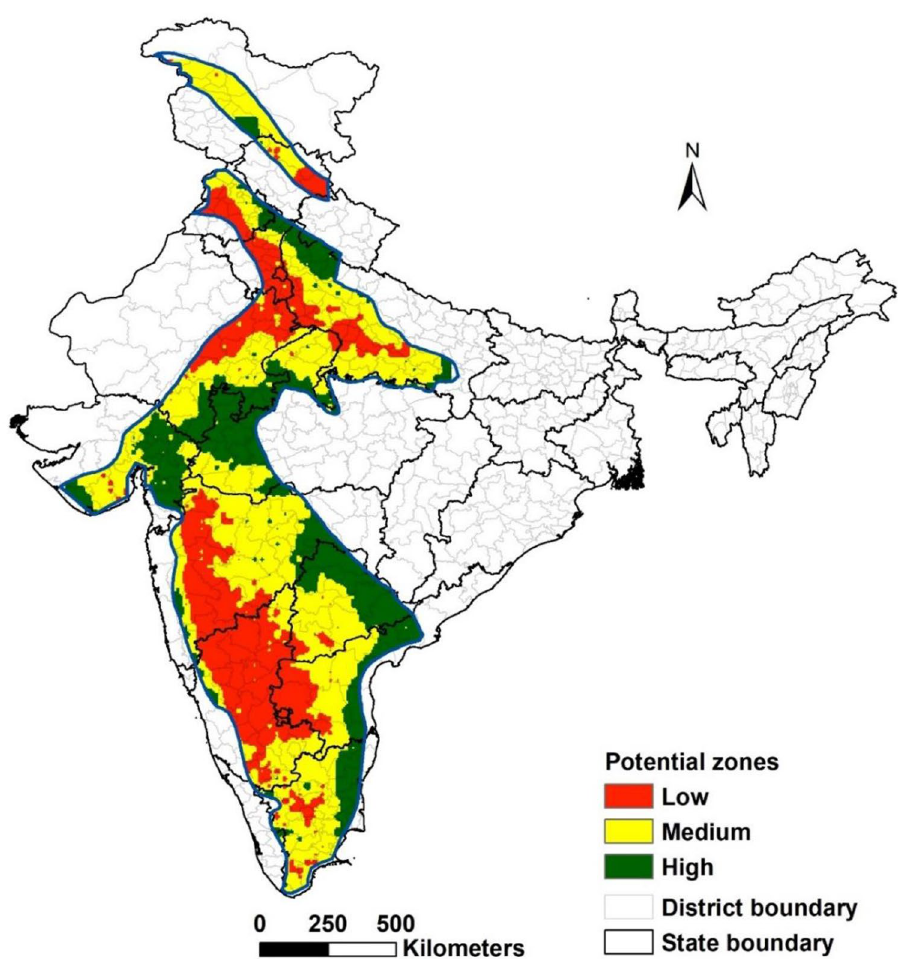
Figure 15. Potential zones to undertake rainwater harvesting interventions in the semi-arid tropics of